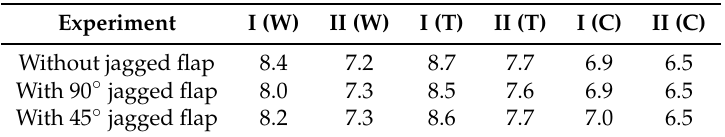
Table 3. ∆ LA eq 1 ( dBA) for experiments I and II when frequencies are ranging from 20 Hz to 5000 Hz. W, T and C represent white, traffic and construction noises, respectively. Results are computed using narrow frequency band with step of 2